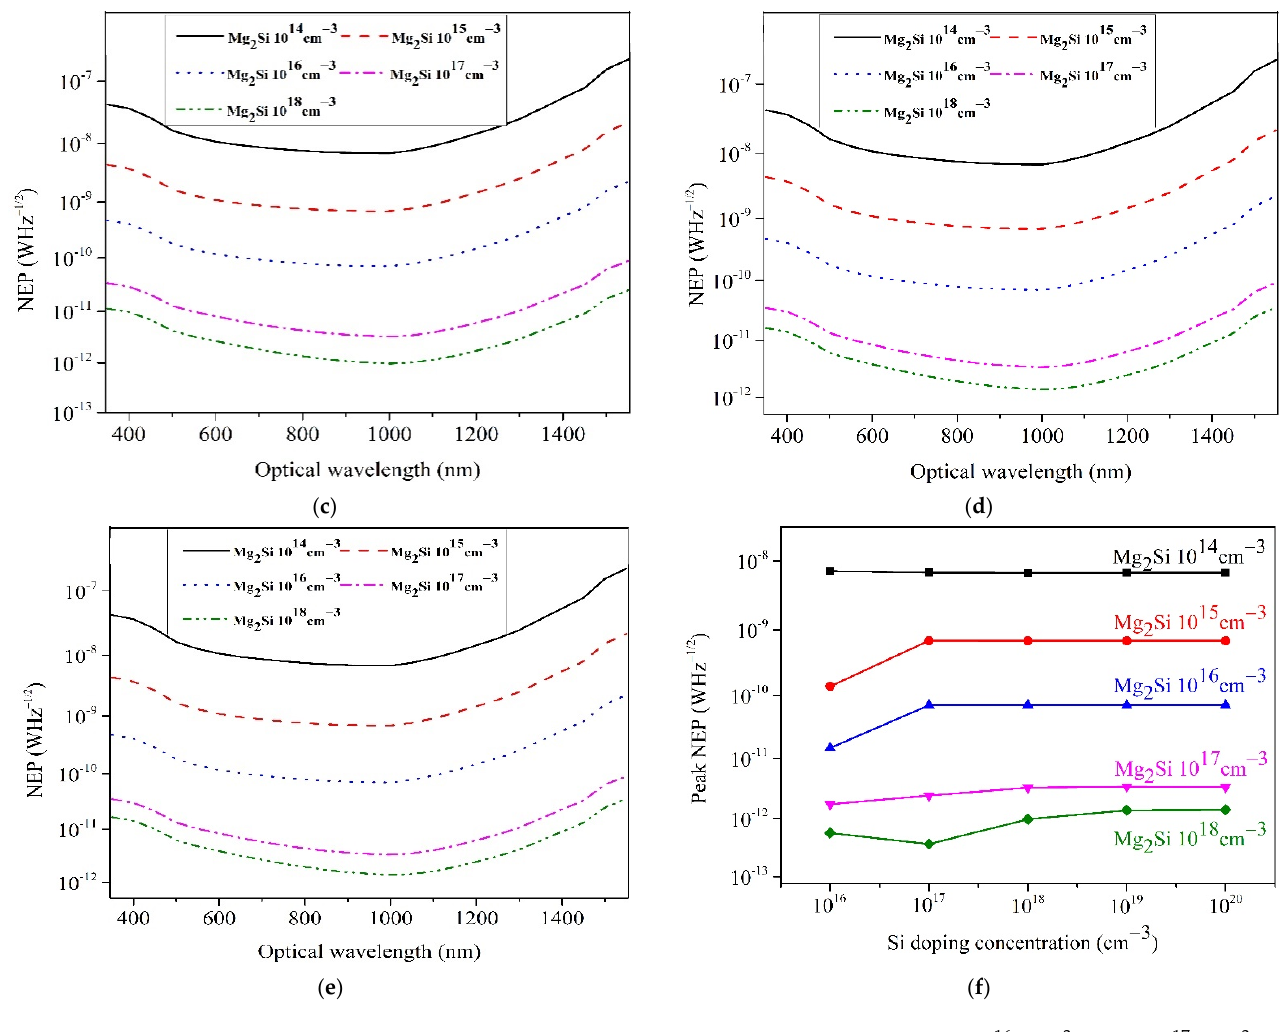
Figure 8. NEP curves of the heterojunction PDs with different doping concentrations. ( a ) Si–10 16 cm − 3 . ( b ) Si–10 17 cm − 3 . ( c ) Si–10 18 cm − 3 . ( d ) Si–10 19 cm − 3 . ( e ) Si–10 20 cm − 3 . ( f ) The effect of doping concentrations on NEP.